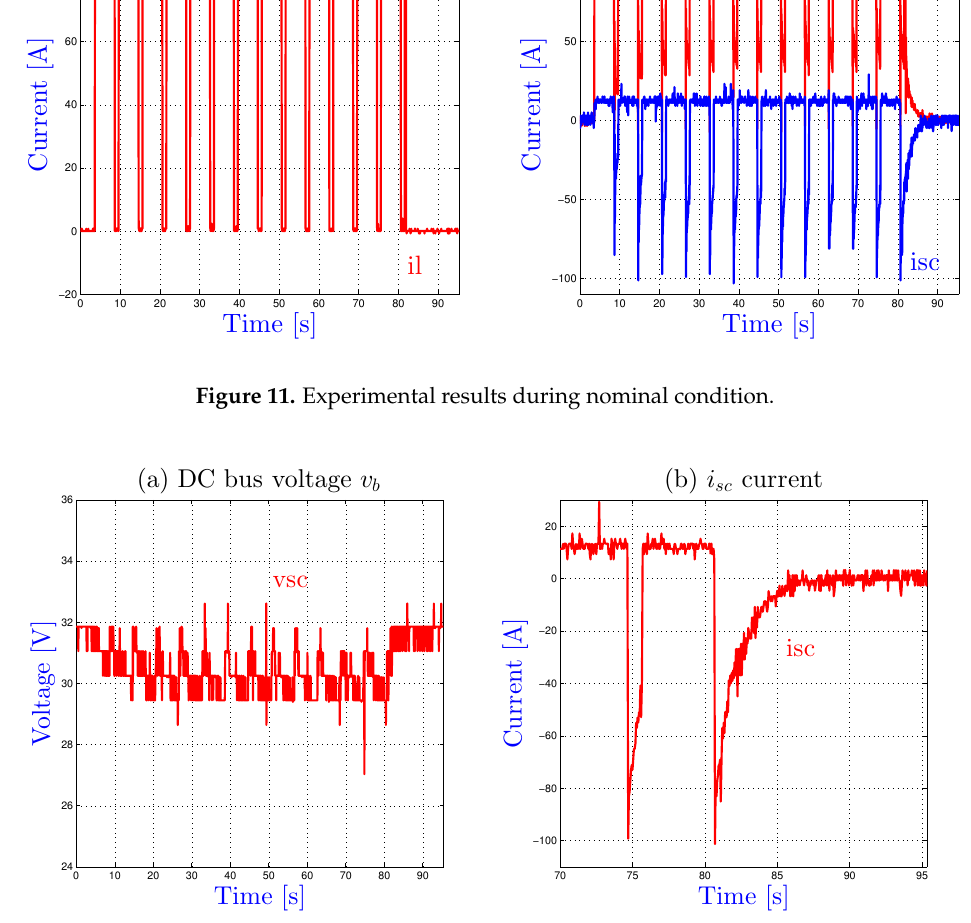
Figure 12. Experimental results during nominal